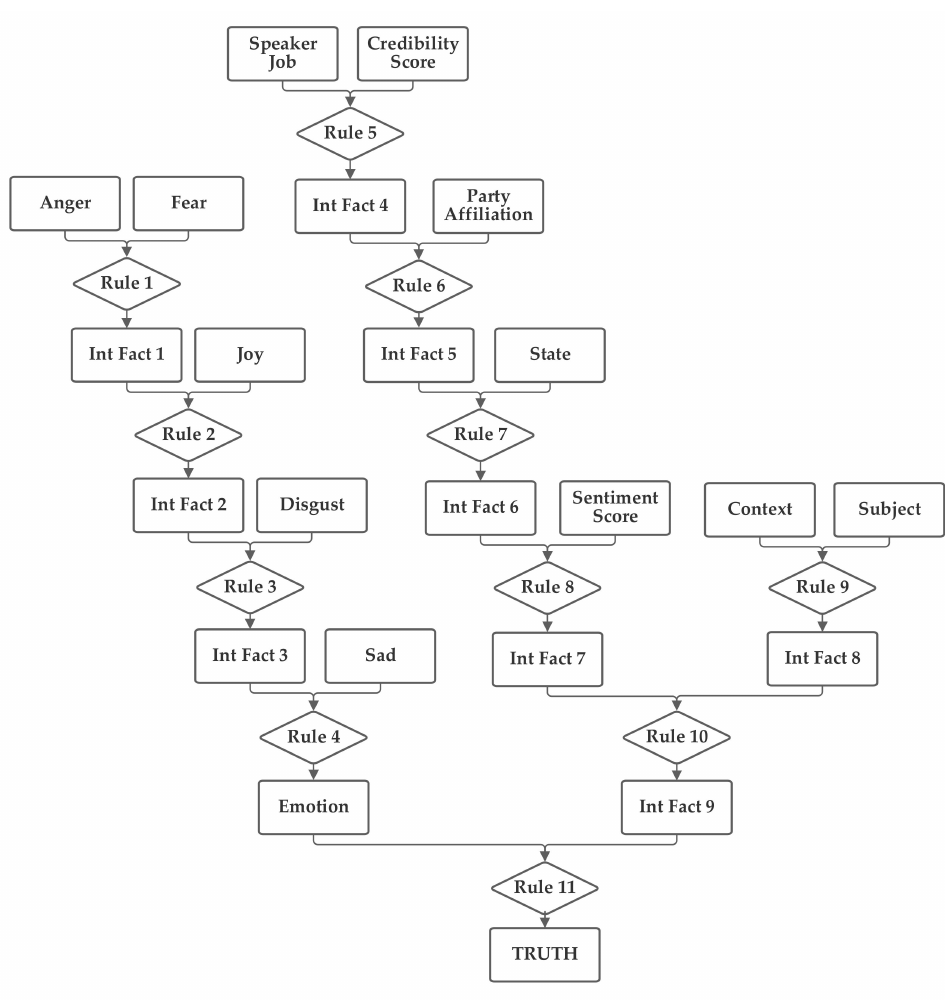
Figure 9. Depiction of Network